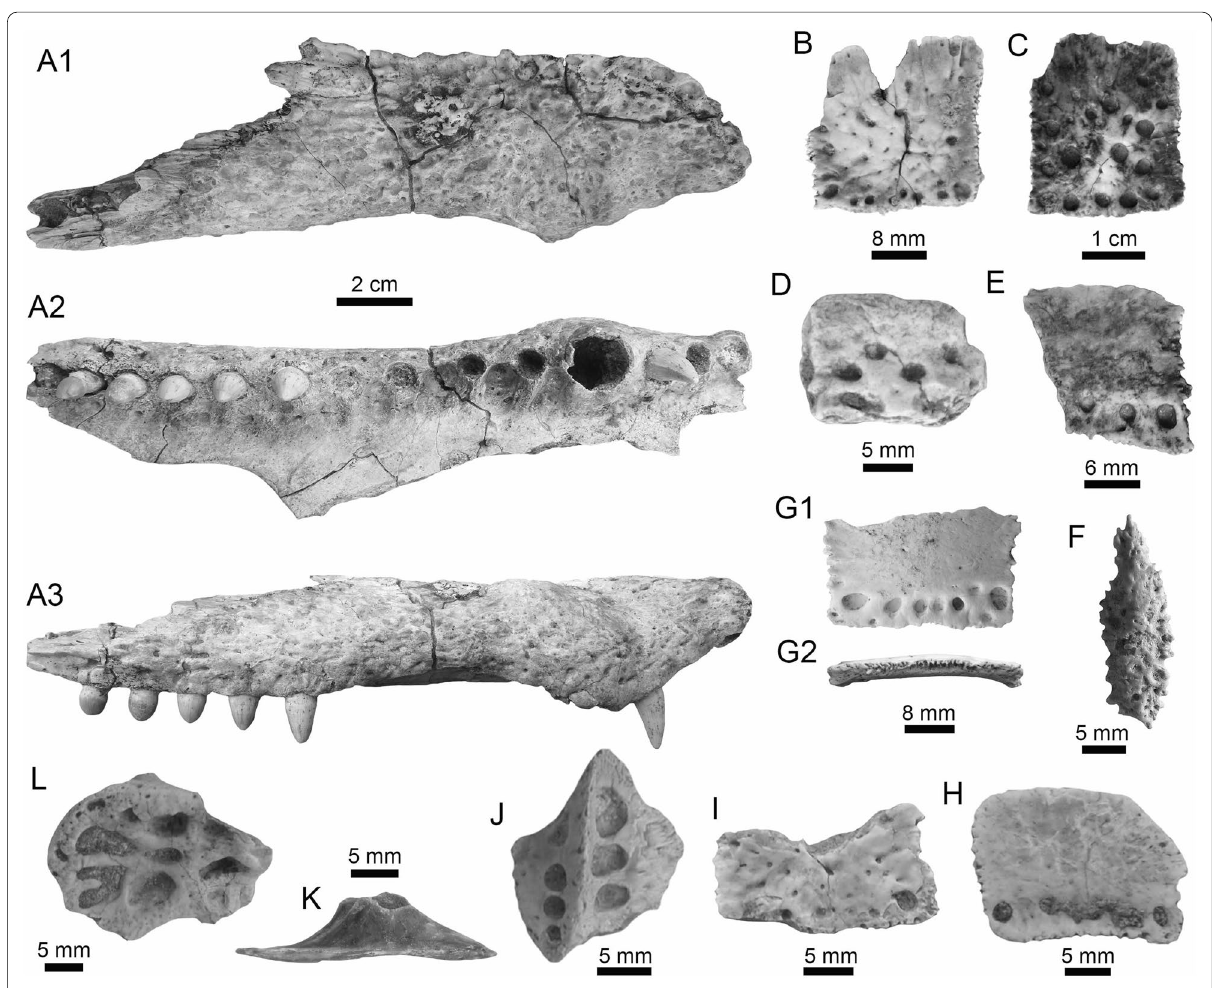
Fig. 19 Crocodylia (Caimaninae) from the Vergel ( B – F , H – L ) and Cocuiza ( A1 – A3 , G1 , G2 ) members. A1 – A3 Right maxilla fragment of Caiman aff. C . yacare (AMU‑CURS‑1328). B – L Caimaninae indet. B – J Osteoderms ( B – D AMU‑CURS‑553, E – F AMU‑CURS‑711, G1 , G2 AMU‑CURS‑1315 and H – J AMU‑CURS‑1060a), skull fragment ( L ), and one cervical rib ( K ) (AMU‑CURS‑1060b). Views: cross sectional ( G2 ), dorsal ( A1 , L ), external ( B – G1 , H – J ), lateral ( K ), right lateral ( A3 ), and ventral ( A2